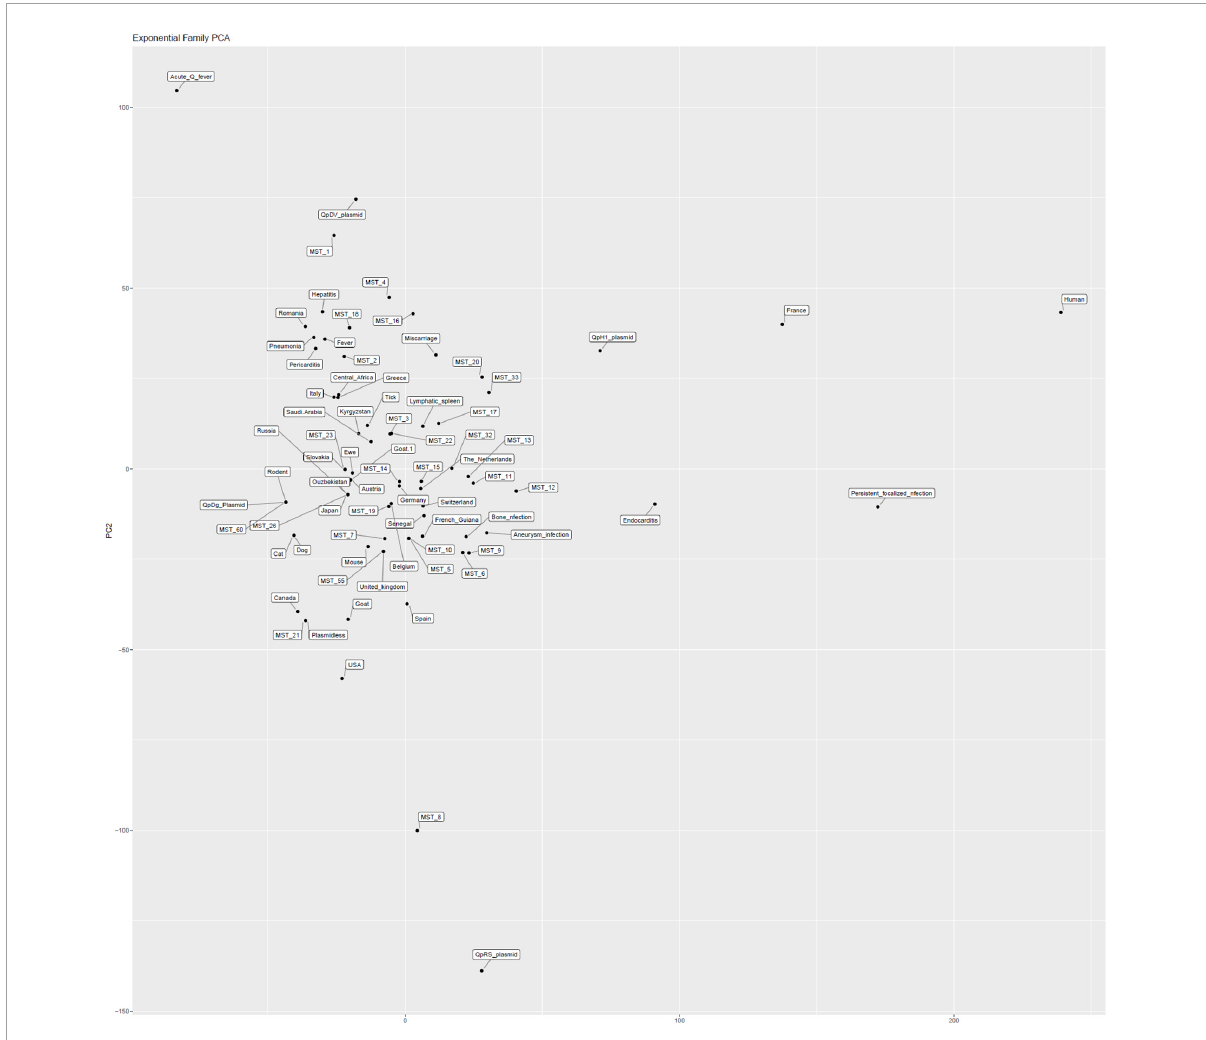
FIGURE6 Logistic (exponential) principal component analysis specifically adapted to the qualitative data.